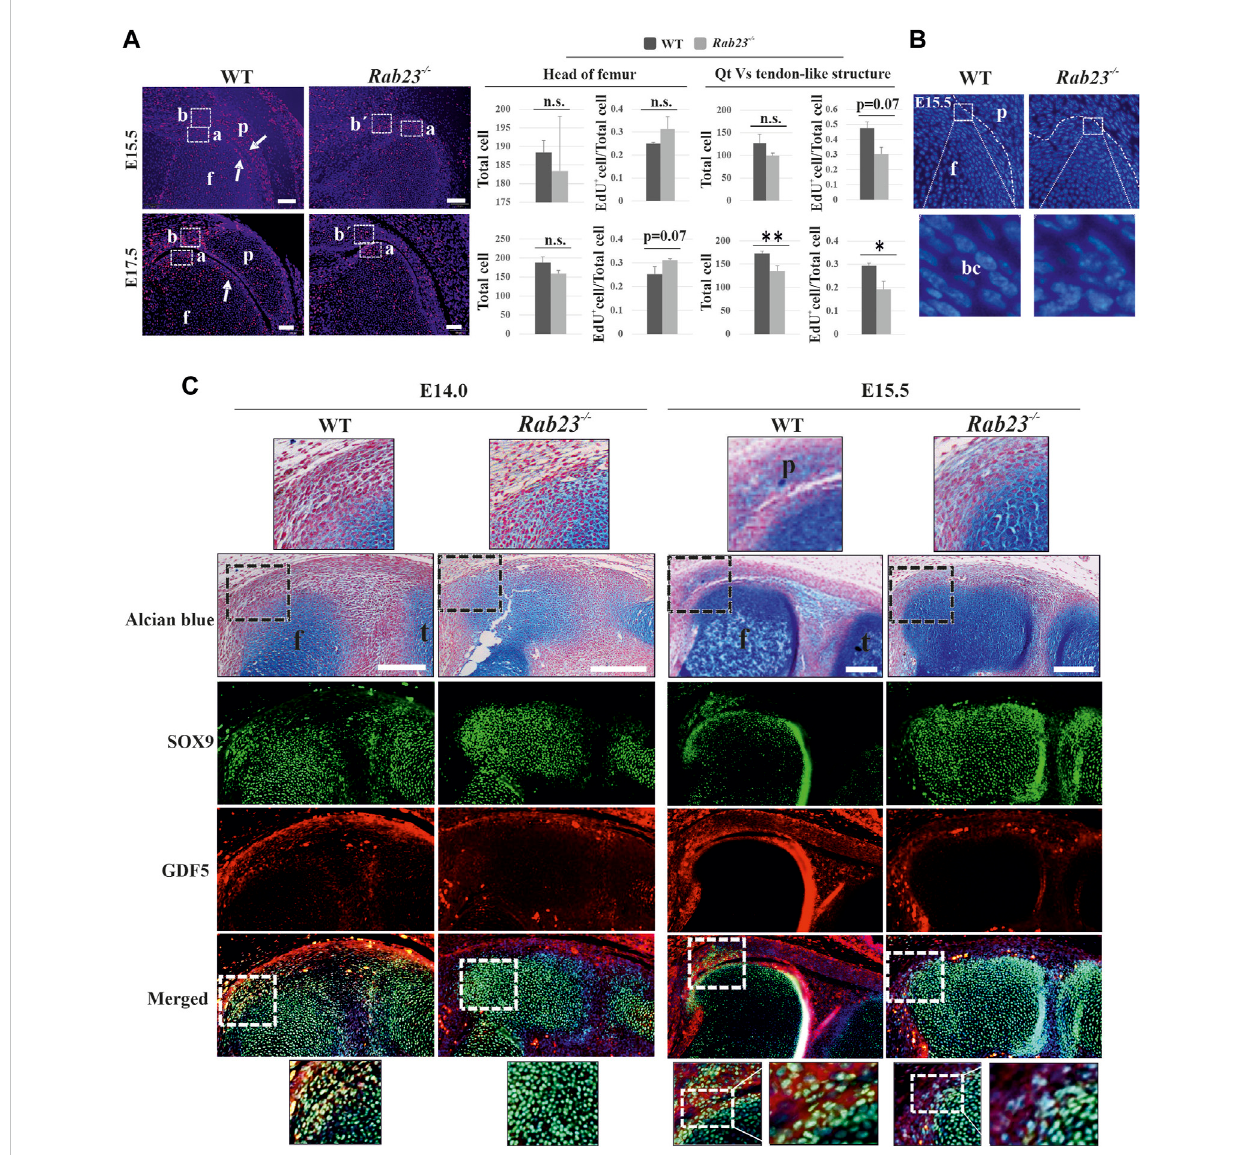
FIGURE 3 Analysis of cell proliferation and the expression of GDF5 in the Wt and Rab23 − / − patellofemoral samples. (A) EdU pulsed cell proliferation analysis in the patellofemoral Wt and Rab23 − / − samples at E15.5 and E17.5. Images show during and after the separation of the patella from the femur, the boundary cells undergo robust cell proliferation in Wt samples at E15.5 and E17.5, (white arrows). On the contrary, no patella and patellofemoral joint were established in Rab23 − / − samples, but showed an expansion of the femur head toward the presumptive patella site. We, therefore, compared cell proliferationattheendofthefemur (A) inWtand Rab23 − / − samplesandalsocomparedthecellproliferationofquadricepstendon (B) inWt vs. tendon-like structure (b´) in Rab23 − / − samples at E15.5 and E17.5. Counting of all cells (blue + EdU + cells) and the ratio of EdU + cells (EdU + cells/all cells) show that proliferativecellsinthefemurheadincreasednon-signi fi cantlyin Rab23 − / − comparedtoWtatE15.5andE17.5.Countingofallcells(blue+EdU + cells)and the ratio of EdU + cells (EdU + cells/all cells) show that proliferative cells in the tendon-like structure decreased signi fi cantly in Rab23 − / − compared to Wt at E15.5 and E17.5 ( n = 3 samples for each genotype). p value ˂ 0.05 (*); p value ˂ 0.02 (**). Nuclei were stained with Hoechst (blue), EdU + cells (red), Qt: quadriceps tendon, p: patella, and f: femur. Scale bar: 100 μ m. (B) Morphological observation of boundary cells of the femur toward the patella in Wt vs. boundary cells of the femur in Rab23 − / − at E15.5. Images show the cell nuclear shape in the boundary cells is fl at and elongated in Wt samples (inset), whereas Rab23 − / − samples show the cell nuclear shape is morphologically irregular (inset). Nuclei (blue), bc: boundary cell. (C) Immunohistochemical analysis of GDF5 and SOX9 in Wt and Rab23 − / − mice sagittal-sectional tissues of the hind limbs at E14.0 and E15.5. Wt samples at E14.0 show GDF5 expression in the interzone cells between the future patella and femur junction where GDF5 mostly co-localizes with SOX9. At E15.5, GDF5 is expressed at the femur and patella periphery closer to the patellofemoral joint. GDF5 is not expressed in Rab23 − / − samples at E14.0 and shows poor expression in the femur head at E15.5 Rab23 − / − samples. To highlight the cartilage cells of the patella, femur and interzone cell sagittal sections from E14.0 and E15.5 hind limbs were stained with Alcian blue and fast red (upper panel). ( n = 3 samples for each age and genotype). p: patella, f: femur, and t: tibia. Scale bar: 200 μ